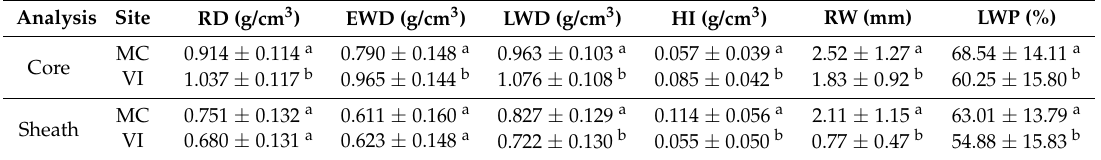
Table 3. Mean values ( ± standard deviation) of the ring width and wood density components measured within the core and sheath analyses at both sites. Mean of 10 trees per site and four stem height levels per tree (RD, ring density; EWD, earlywood density; LWD, latewood density; HI, heterogeneity index; RW, ring width; and LWP, latewood